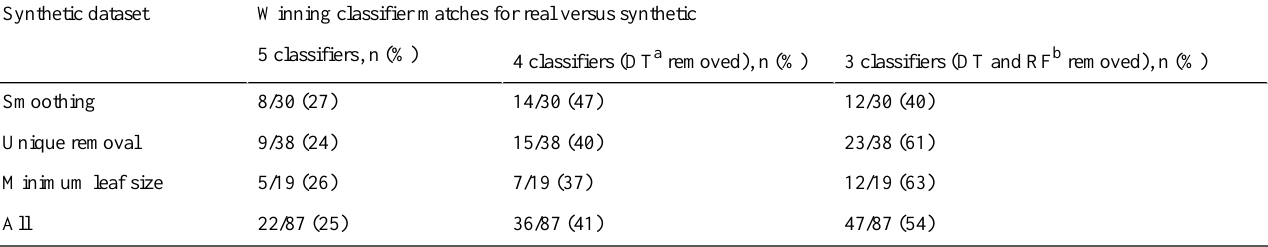
Table 9. Number of instances where the winning classifier trained on synthetic data with statistical disclosure control applied matches the winning classifier trained on real data across 19 datasets.